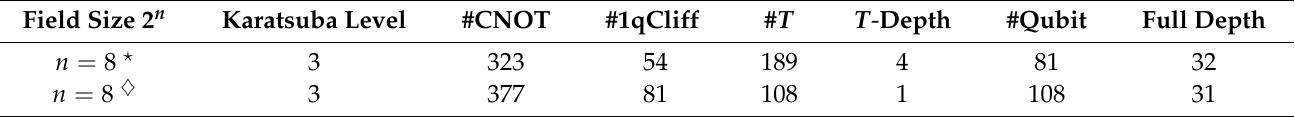
Table 5. Resources required for quantum multiplication of F 2 8 / ( x 8 + x 4 + x 3 + x + 1 ) .